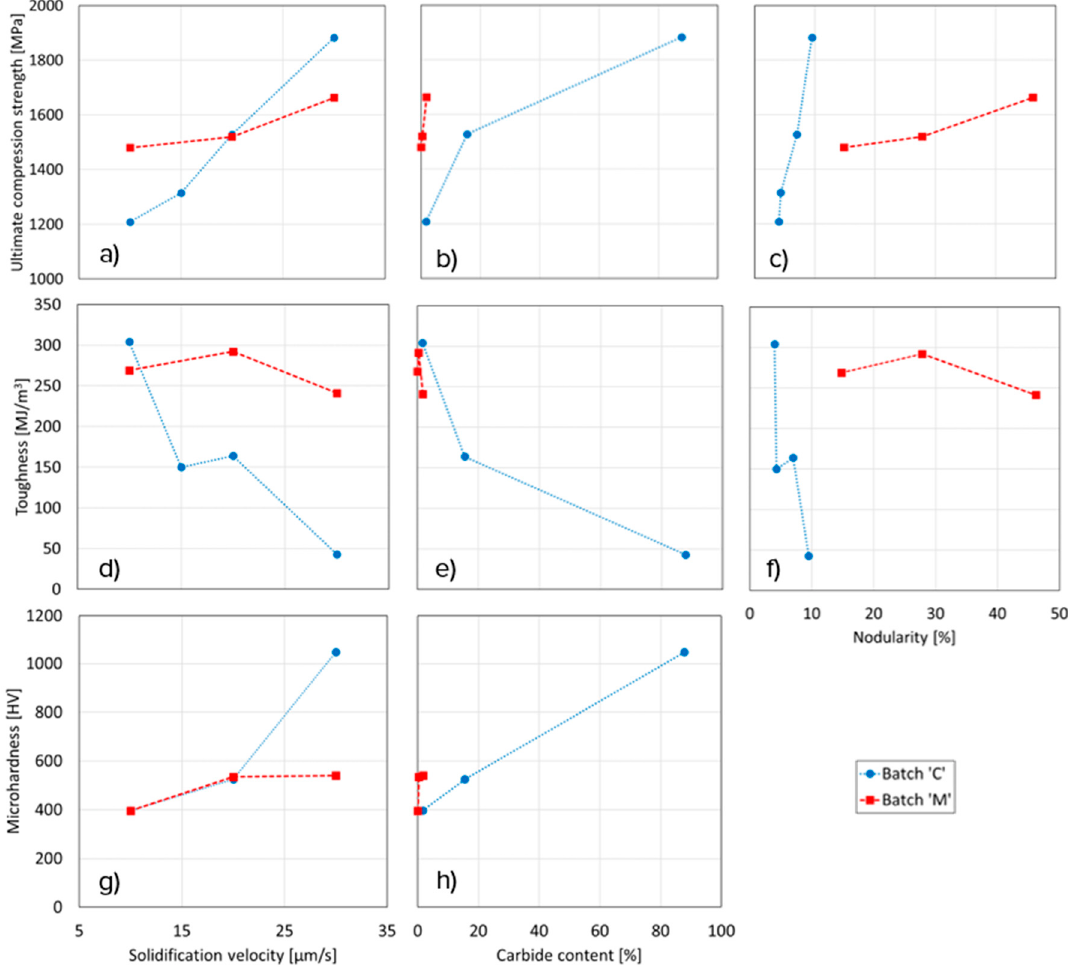
Figure 3. Correlation of ultimate compression strength (first row: a – c ), toughness (middle row: d – f ) and microhardness (bottom row: g , h ) from the solidification velocity (first column: a , d , g ), carbide content (middle column: b , e , h ) and nodularity (last column: c , f ).